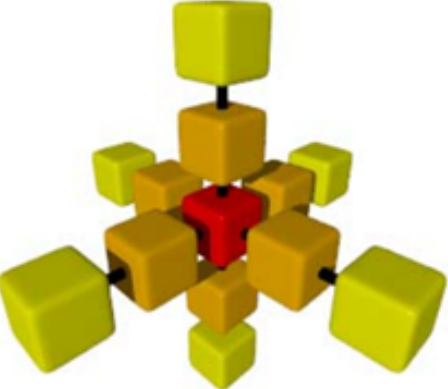
Figure 5. Points operated to obtain each point in an iteration of the